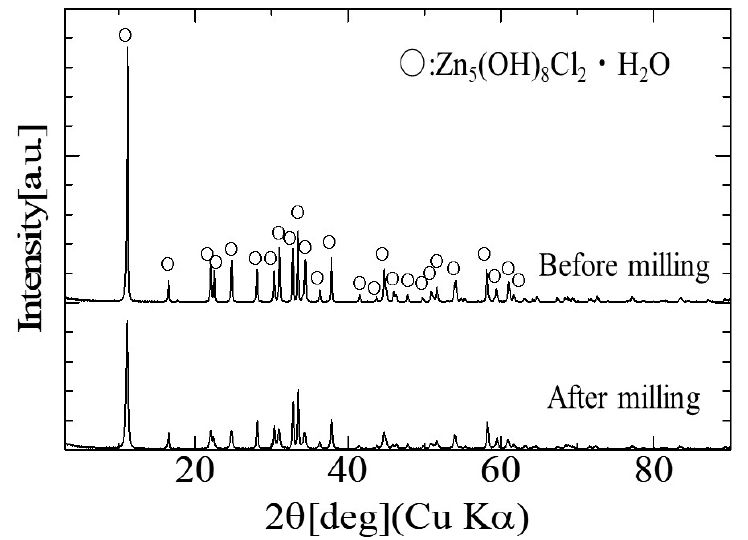
Figure 2. The X-ray diffraction patterns of simonkolleite before and after ball milling for 72 h.